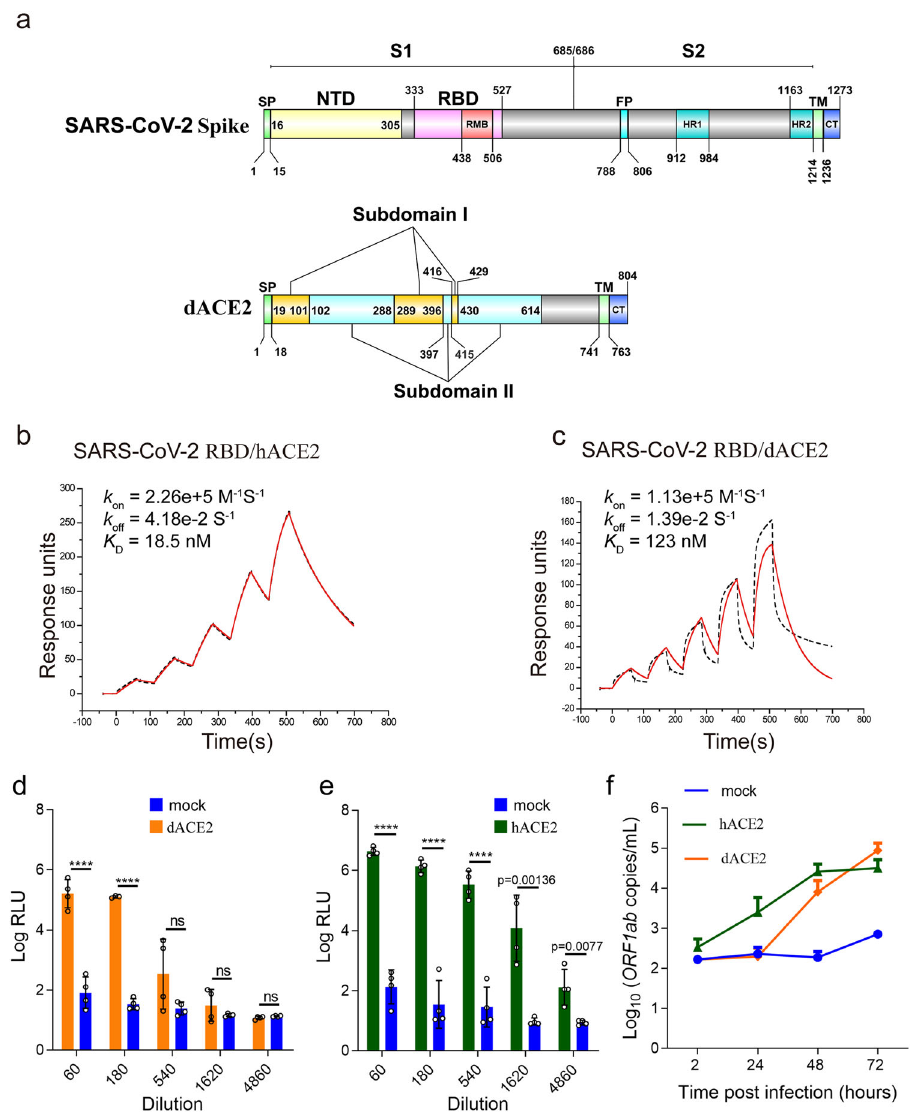
Fig. 1 The binding af fi nity of RBD to both hACE2 and dACE2, and the infection ef fi cacies of pseudovirus and authentic virus in hACE2- and dACE2- expressing BHK21 stable cells. a Schematic of SARS-CoV-2 S ( fi rst panel) and dACE2 (second panel) linear compositions colored per domain. b SPR- binding curves for immobilized hACE2 with the soluble RBD. c SPR-binding curves for immobilized dACE2 with the RBD. The black dashed lines represent the actual data, while the red solid lines represent the fi tted results ( b , c ). d Infection of dACE2-expressing BHK21 cells with SARS-CoV-2 S protein-bearing pseudovirus. e Infection of hACE2-expressing BHK21 cells with SARS-CoV-2 S protein-bearing pseudovirus. **** p < 0.0001; ns means no signi fi cant differences; two-tailed Student ’ s t -test. The experiment was performed with quintuplicate cell samples ( d , e ). f Infection of dACE2/hACE2-expressing HeLa cells with SARS-CoV-2 authentic virus. The experiment was performed with duplicate cell samples. Data are presented as mean values± SD ( d – f